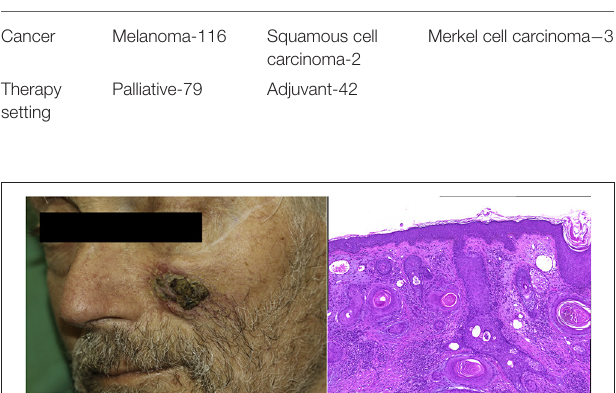
FIGURE 1 | Clinical presentation and histopathology of squamous cell carcinoma. (A) 3 × 3cm solitary subcutaneous hardened plaque with central ulceration. (B) Squamous cell carcinoma (H&E staining, 200 ×